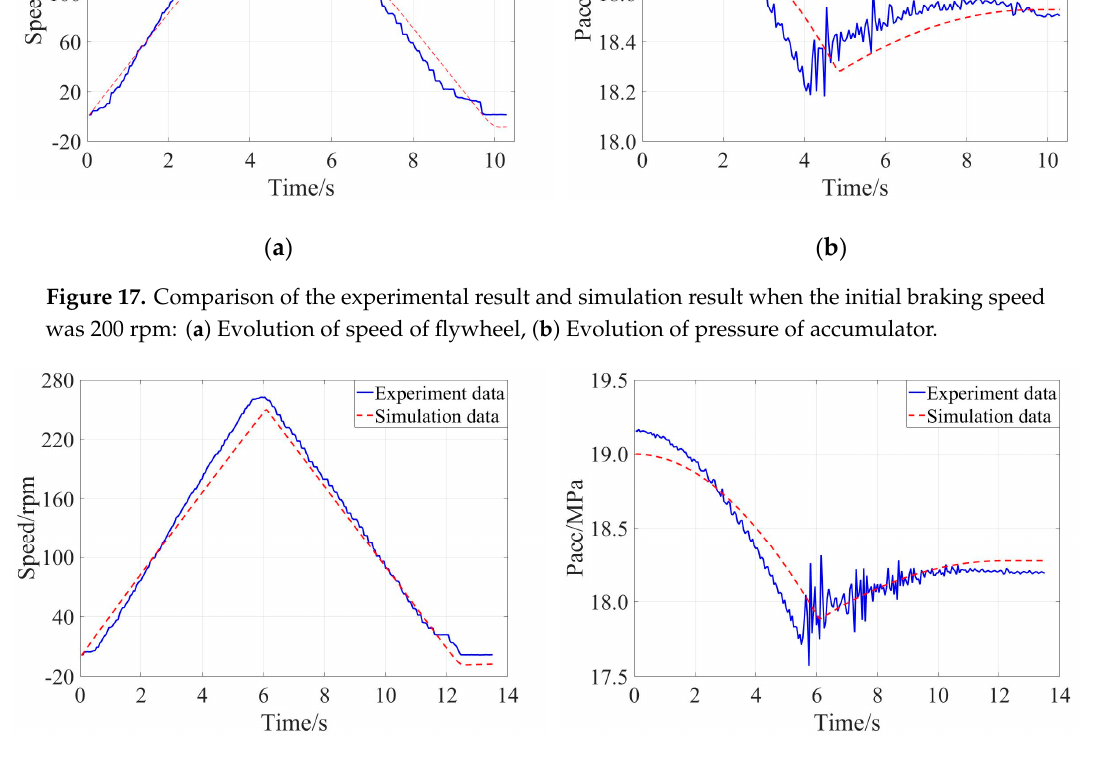
Figure 18. Comparison of the experimental result and simulation result when the initial braking speed was 250 rpm: ( a ) Evolution of speed of flywheel, ( b ) Evolution of pressure of accumulator.